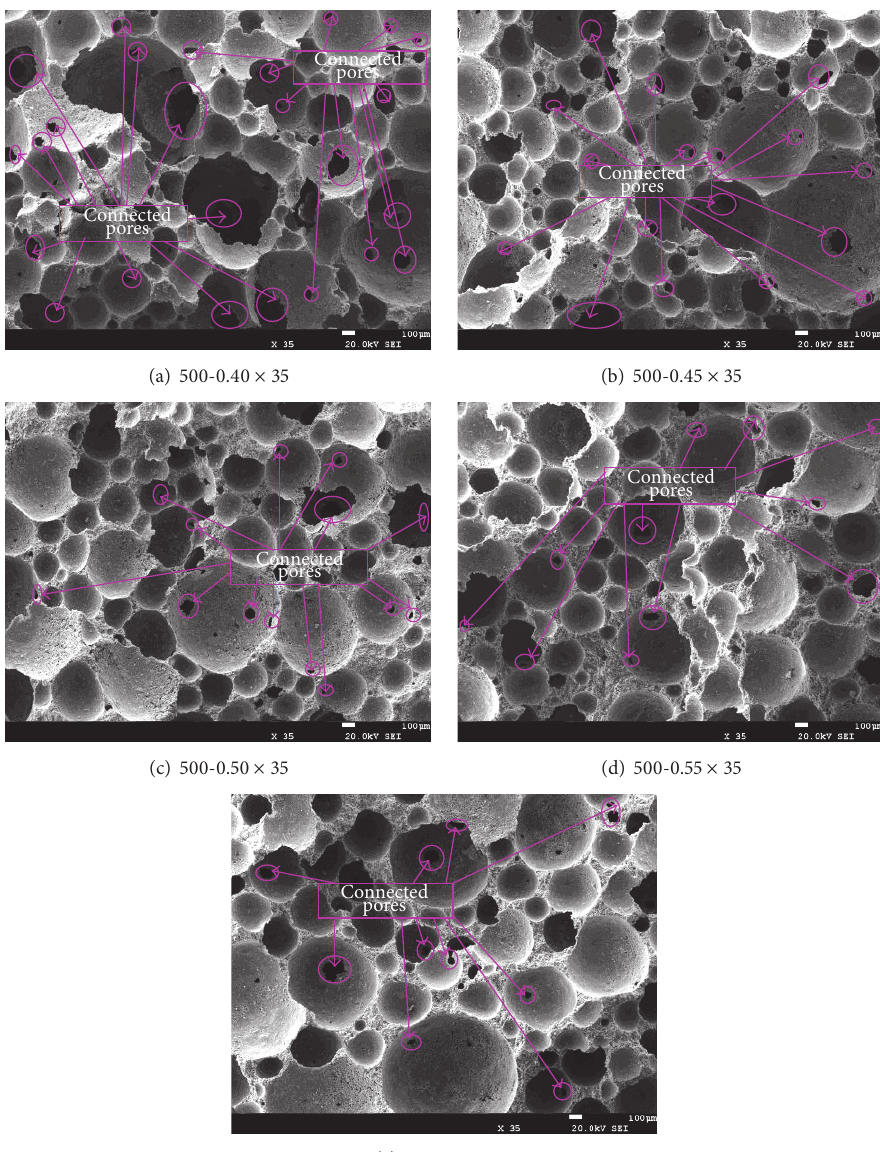
Figure 2: SEM images of the 500 kg/m 3 foam concrete of different w/c